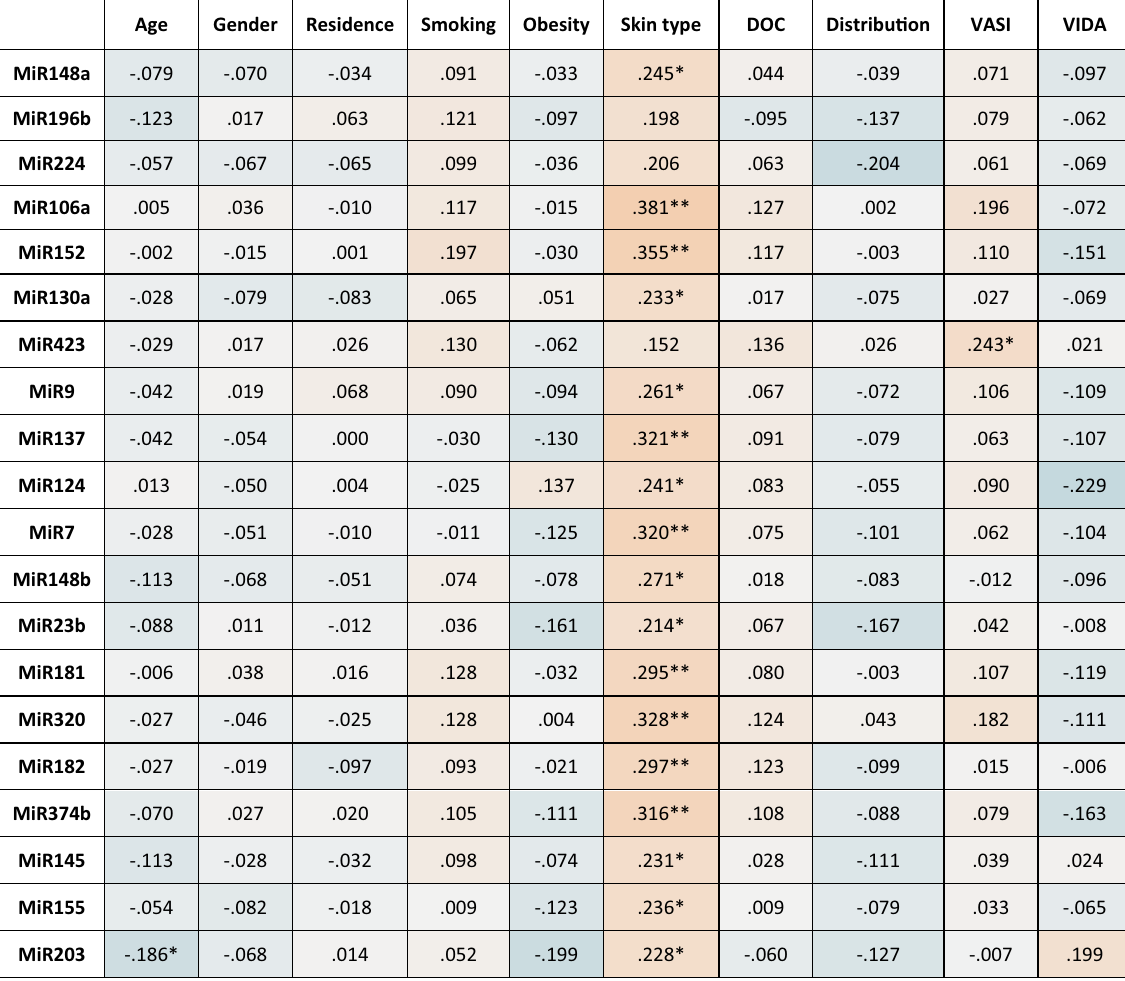
Table 5. Correlation matrix between miRNAs understudy and clinical characteristics of vitiligo patients. Spearman’s Correlation coefficient are presented for the 20-miRNAs among vitiligo patients’ understudy. **Correlation is significant at the 0.01 level (2-tailed). *Correlation is significant at the 0.05 level (2-tailed). DOC duration of complain, VASI vitiligo area severity index, VIDA vitiligo disease